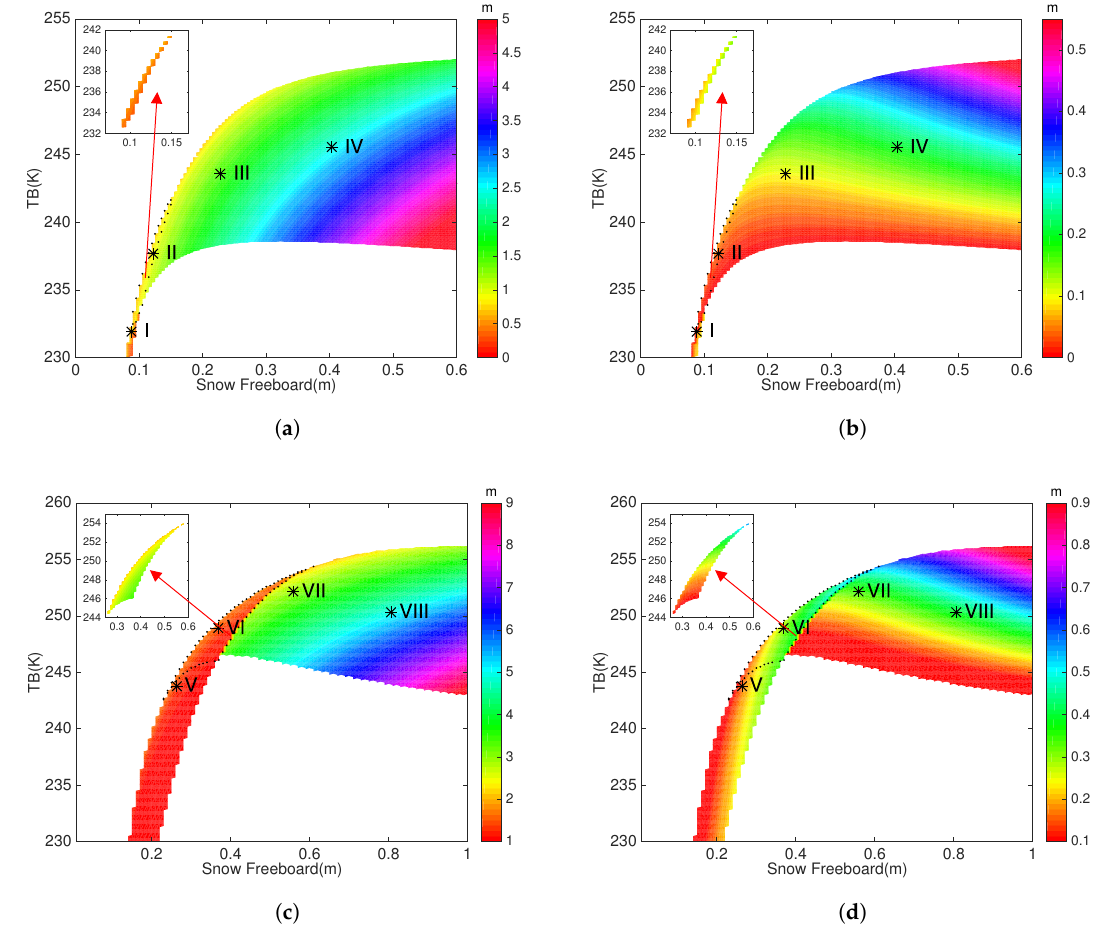
Figure 4. Same as Figure 3 but for the synergy between TB and FB snow . Subfigures are ordered as in Figure 3, with ( a , b ) showing the sol2zuole tion space of hi and hs for FYI respectively, and ( c , d ) showing those for